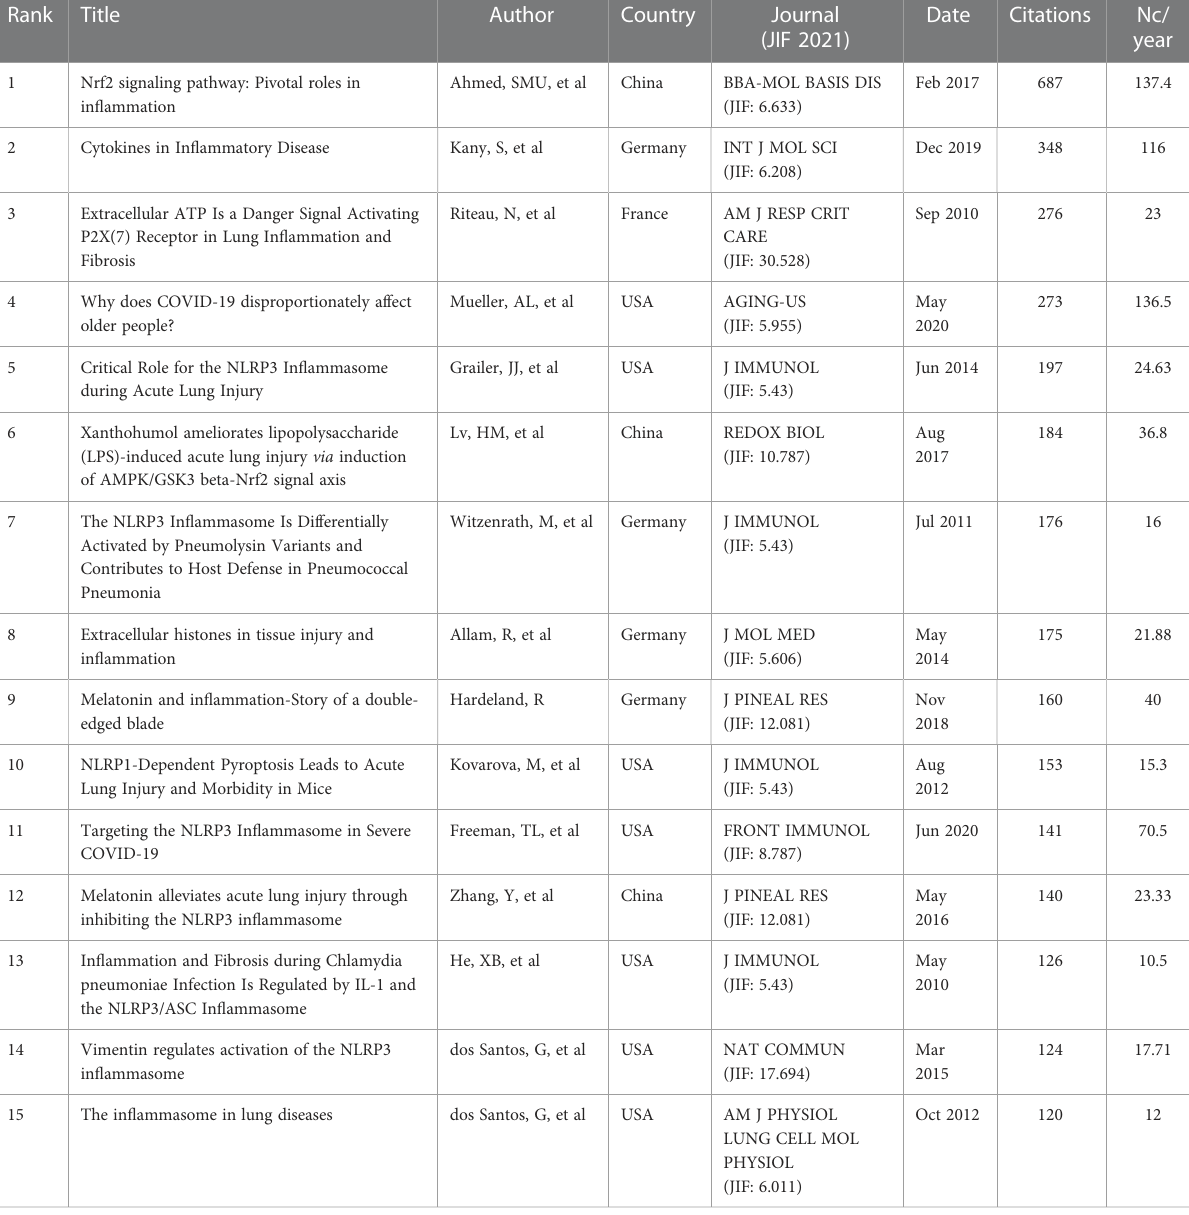
TABLE 5 The top 15 papers with the highest number of